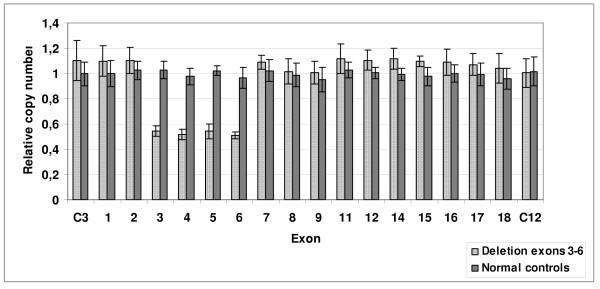
Mean relative copy numbers of exons in the LDL receptor gene. Mean relative allele copy number ± SD of LDL receptor gene exons 1–9, exons 11–12, exons 14–18, 5' (C3) and 3' (C12) flanking control fragments in 14 patients with a 9 kb deletion of exons 3–6 measured with MLPA analysis compared to mean relative copy number in 12 normal controls.